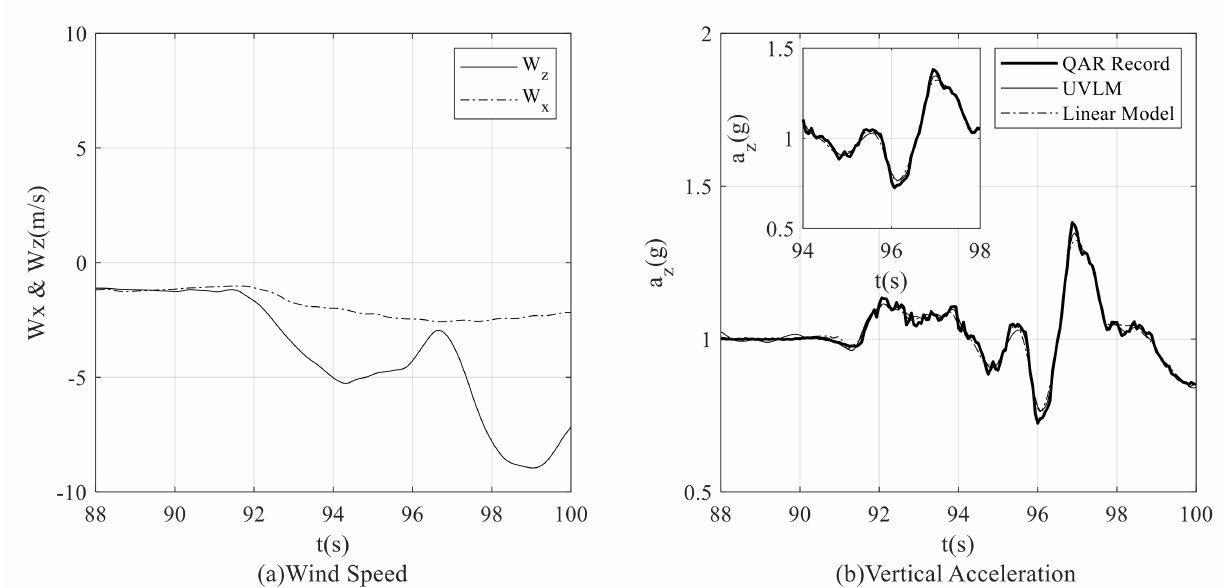
Figure 9. Turbulence components and acceleration response in WF5.